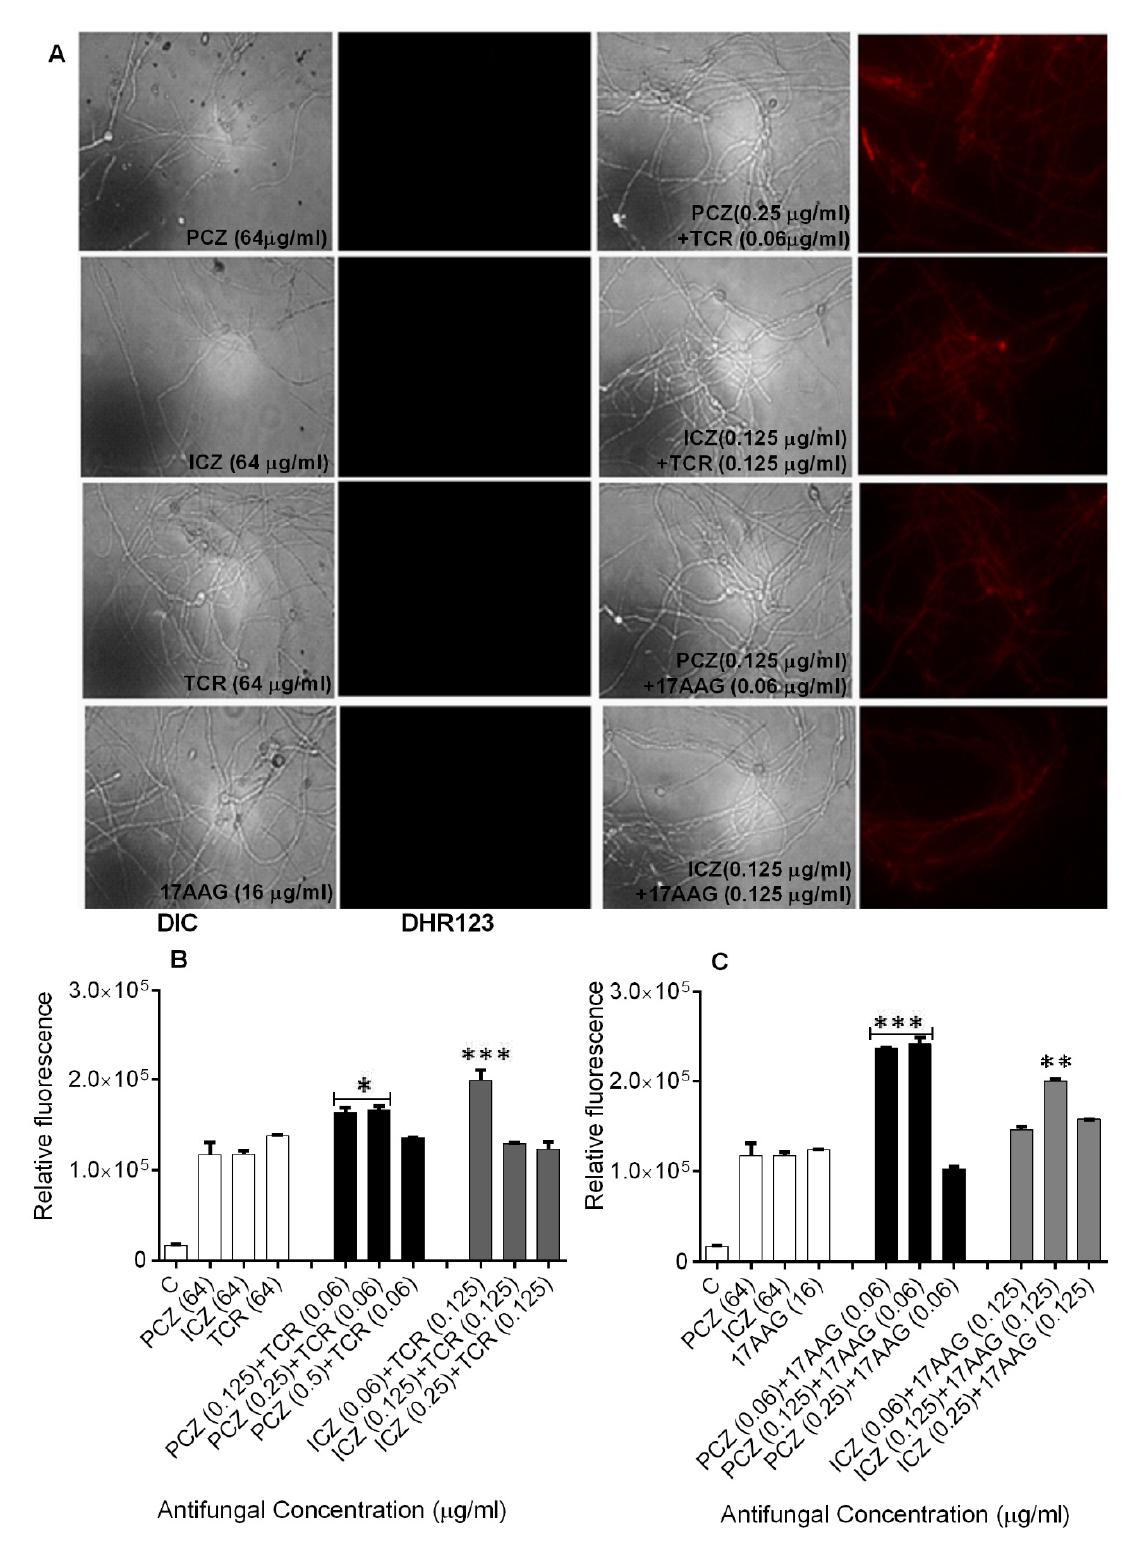
FIGURE 2: Intracellular ROS accumulation as detected by DHR-123 in S. prolificans isolate 1 germlings treated with PCZ or ICZ with either TCR or 17AAG, was measured using fluorescence spectrophotometry. (A) Fluorescent images of S. prolificans stained with DHR-123. (B) Relative fluorescence levels in S. prolificans germlings treated with PCZ or ICZ in combination with TCR. (C) Measurement of fluorescence of germlings treated with PCZ or ICZ in combination with 17AAG. *p<0.05; **p<0.001; ***p<0.0001. Error bars on graphs indicate standard de- viation. DIC, differential interference